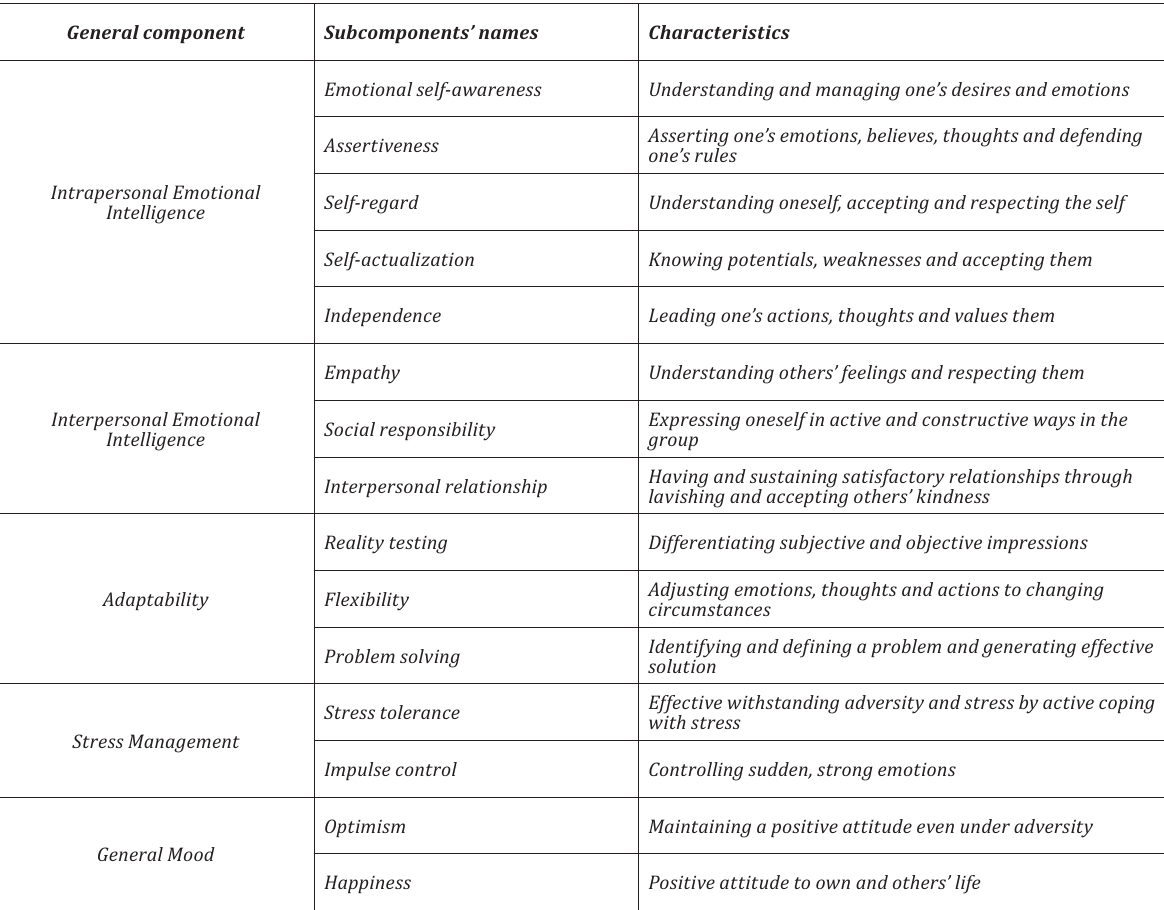
Table 1. The Bar-On’s Emotional Intelligence Model [2, 3,